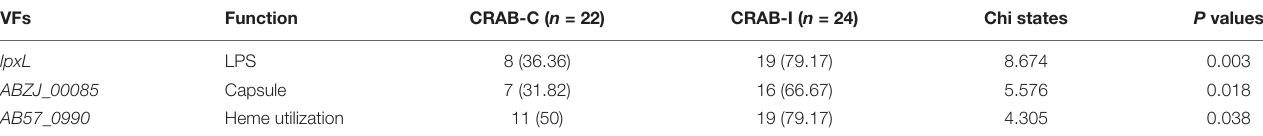
TABLE 1 | The Virulence genes with significant difference between infection and colonization groups of carbapenem-resistant Acinetobacter baumannii . VFs Function CRAB-C ( n = 22) CRAB-I ( n = 24) Chi states P